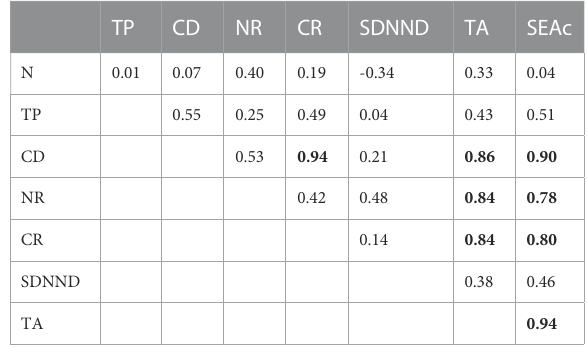
TABLE 5 Correlation matrix (Pearson r coef fi cient) among sample number (n), trophic position (TP), mean distance to centroid (CD), nitrogen range (NR), carbon range (CR), standard deviation of nearest neighbor distance (SDNND), total area (TA), and corrected standard ellipse area (SEAc) of the 12 Callinectes sapidus populations included in the individual-scale dataset. Allmetricslog-transformedandmean-centeredbeforeanalysis.Signi fi cant correlations with p < 0.05 are highlighted in